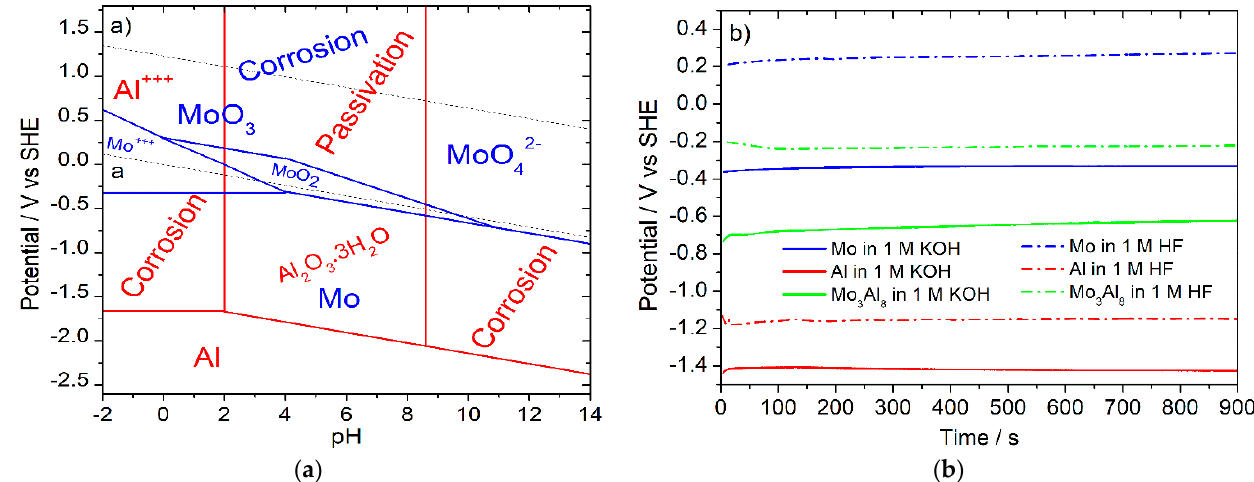
Figure 7. ( a ) Superimposed Pourbaix diagrams of pure Al and Mo showing the regions of stability, passivation and corrosion of each element. ( b ) Evolution of the open-circuit potential of pure Al and Mo, as references, and the as-quenched Mo 3 Al 8 ribbon.